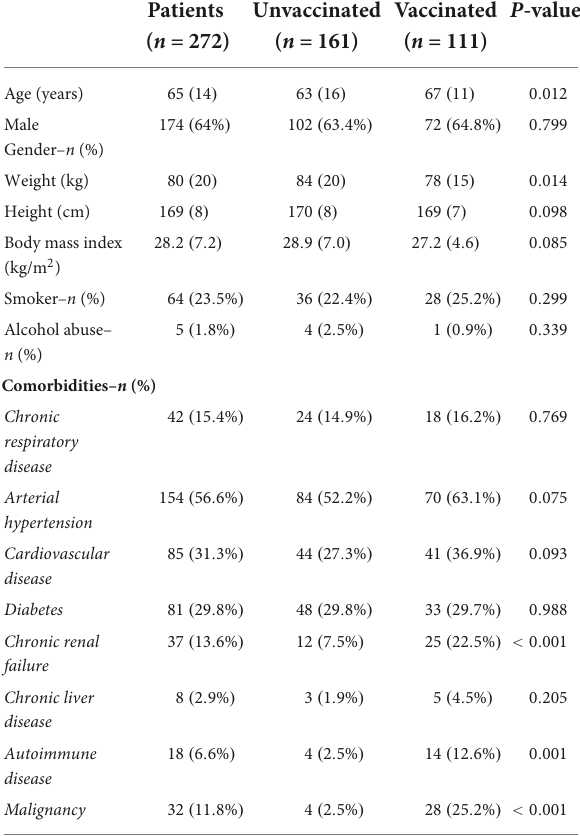
TABLE 1 Demographic characteristics and